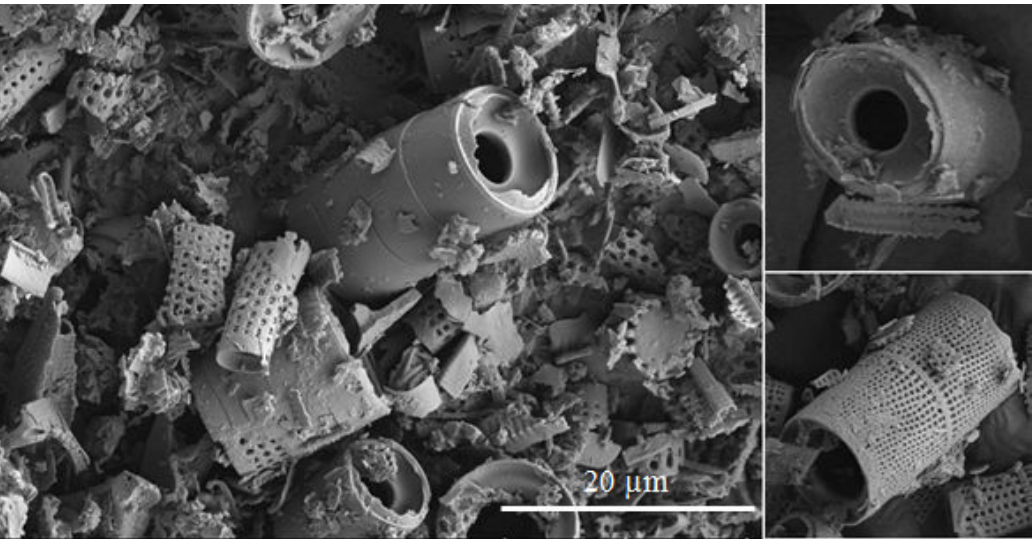
Figure 2. Base diatomaceous earth containing both fractured and non-fractured frustules, with a dominant content of Aulaco- seira.